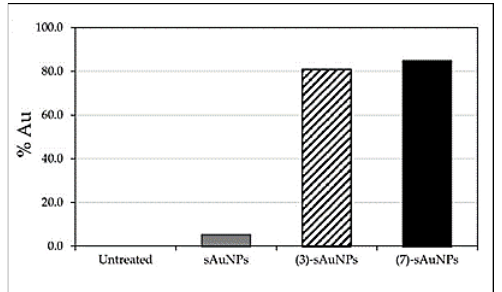
Figure 7. ICP-OES of cellular uptake of sAuNPs and its nanoconjugates by the MCF-7